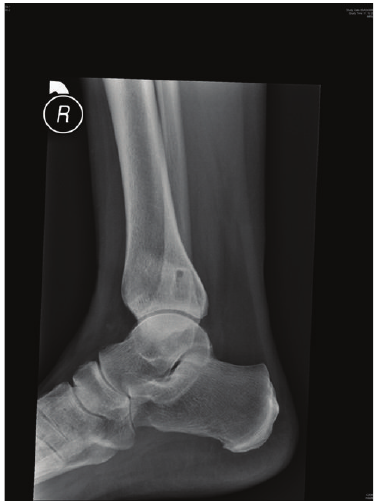
Figure 1: Lateral view X-ray of the ankle showing well defined cystic lesion in distal tibia.